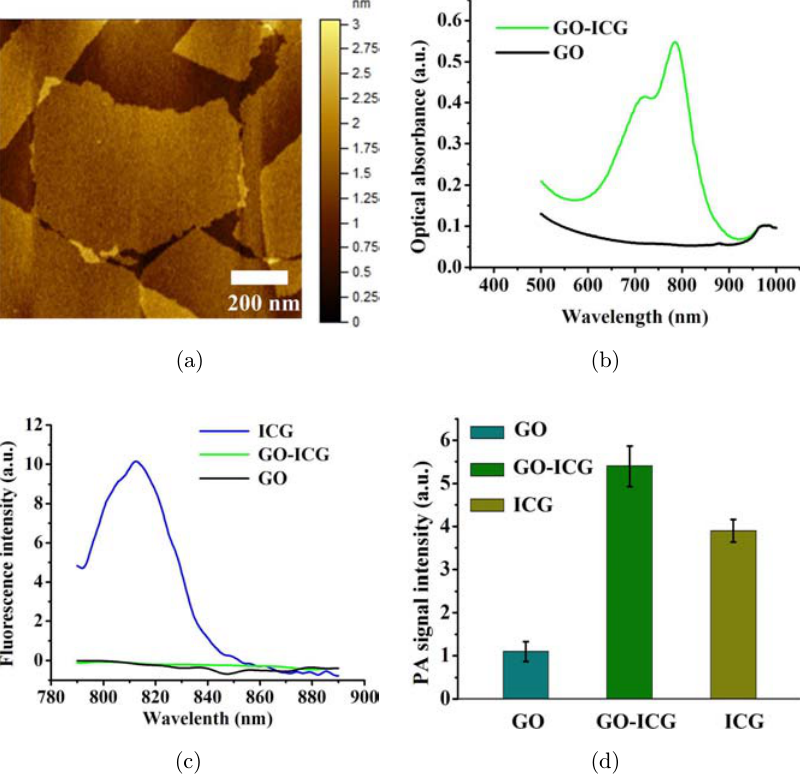
Fig. 2. Characterization of GO-ICG. (a) Atomic force microscopy image of GO. The imaging size is 1 (cid:5) 1 (cid:4) m 2 . (b) UV-visible absorption spectrum of GO and GO-ICG. (c) Fluorescence spectra of ICG (blue line), GO-ICG (green line) and GO (black line). (d) Photoacoustic signal intensities of GO-ICG, GO and